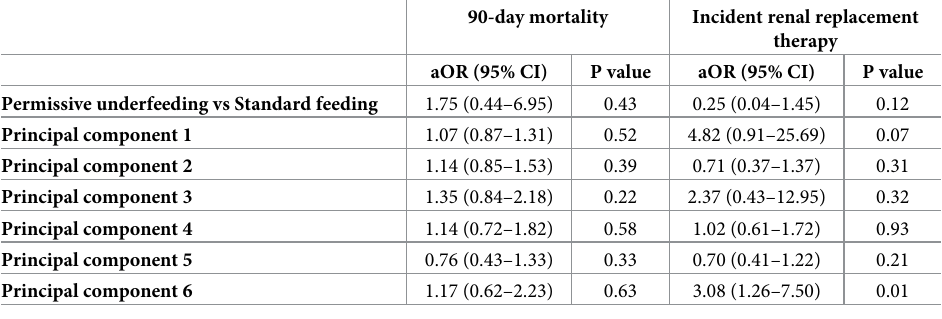
Table 4. The association of permissive underfeeding compared to standard feeding with 90-day mortality and incident renal replacement therapy adjusted for the principal components of the